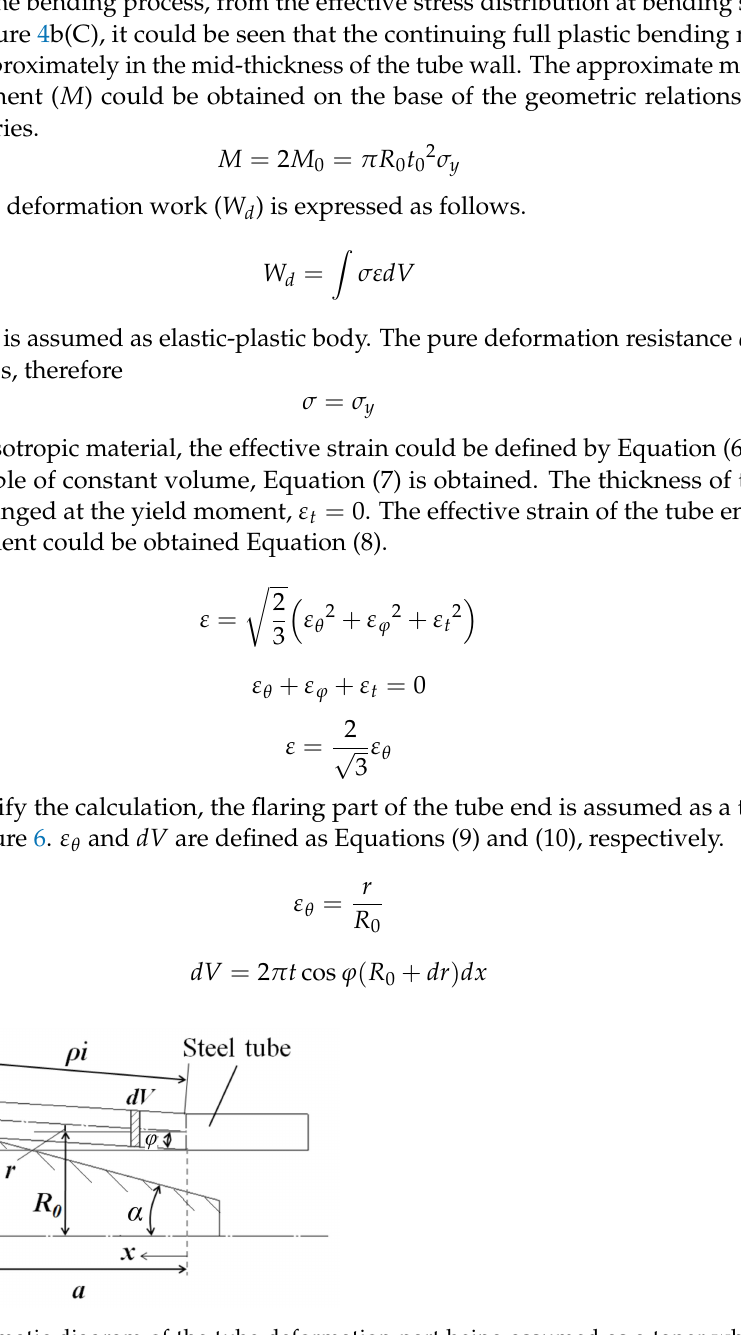
Figure 6. Schematic diagram of the tube deformation part being assumed as a taper when yield- ing